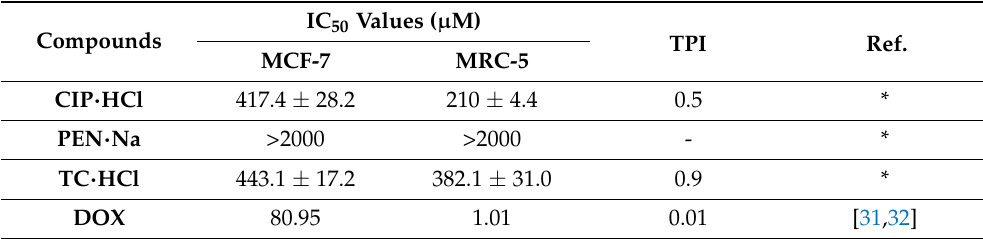
Table 3. IC 50 values of the antibiotics and doxorubicin against adenocarcinoma breast cell line MCF-7 (hormone-dependent) and normal human lung fibroblast cell line MRC-5. IC 50 Values ( µ Compounds